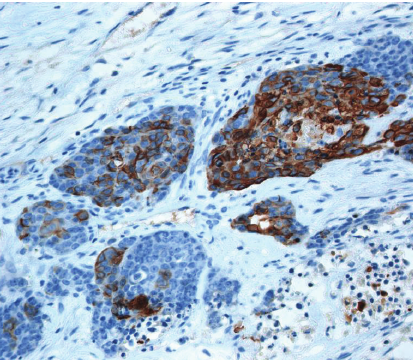
Figure 7: CA125 is positive in scattered tumor cells (SABC tech-